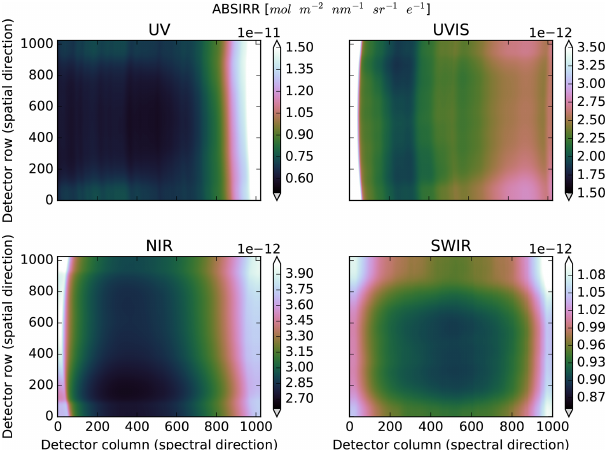
Figure 16. Image plots of absolute irradiance CKD of QVD1 for all spectrometers. The dark blue pixels are where the ABSIRR is off the scale, which corresponds to a responsivity close to zero. The values at the edge of the detectors are calculated with nearest-neighbour